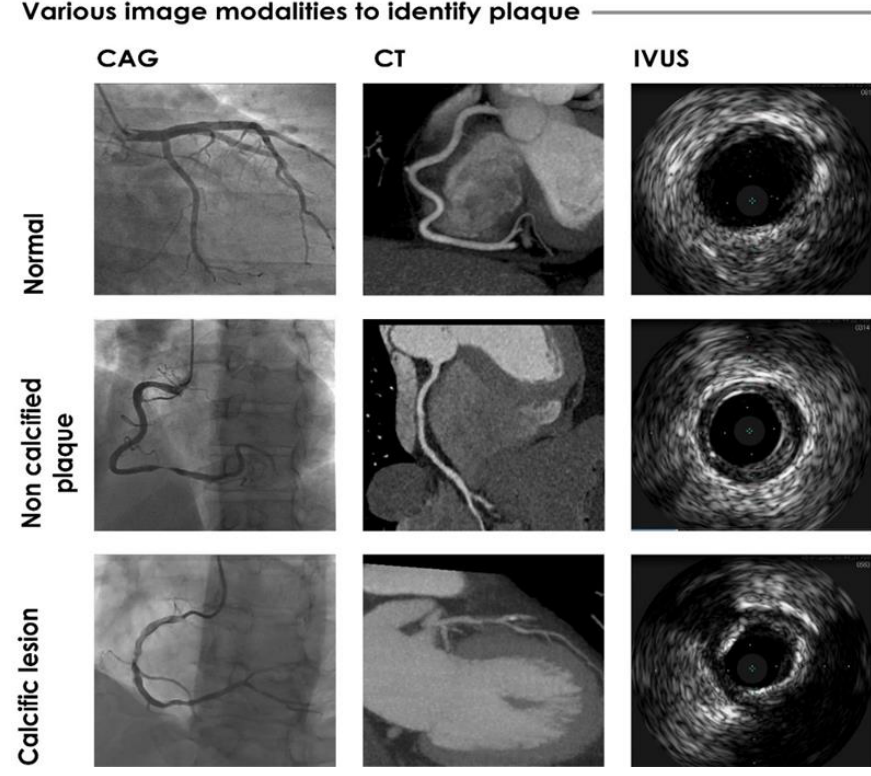
Figure 2. Sample images from invasive CAG, CT, and IVUS imaging techniques. Invasive CAG is the gold standard for coronary artery disease diagnosis based on detection of coronary lumen stenosis but is of limited utility for plaque characterization beyond outlining intracoronary thrombus associated with ruptured atherosclerotic plaque. Nevertheless, invasive CAG is a prerequisite for plaque characterization with IVUS and IVOCT. IVUS is the gold standard for assessment of the atherosclerotic coronary plaque [19,20]. A miniaturized ultrasound probe is introduced intra-luminally via an in- travascular catheter to the coronary lesion to obtain near-field two-dimensional cross-sec- tional high-resolution real-time images of the coronary lumen and atherosclerotic plaque with high echogenic grey-scale signal contrast [21,22]. IVUS is able to distinguish the inti- mal, medial, and adventitial layers of the arterial wall as well as various components of the atherosclerotic plaque, including the presence of dense calcium (DC), necrotic core (NC), fibrotic tissue (FT), and fibrofatty tissue (FFT) [23,24]. It yields comprehensive quan- titative information on lumen size, plaque components and presence of vulnerable plaque features or complications, e.g., TCFA or plaque surface rupture, which herald an immi- nent acute coronary event [25]. VH-IVUS uses spectral analysis of the backscattered grey- scale IVUS radiofrequency signals to augment tissue contrast among the various plaque components [26]. The results are displayed in color codes, which enhances visualization of pathology. Instead of sound waves, IVOCT exploits light waves to produce near-field plaque images with superior spatial resolution (approximately 15 um versus 150 um for IVUS) and tissue discrimination but less imaging depth (few millimeters versus five to ten millimeters for IVUS), which may unveil surface details not appreciated on IVUS [27]. Calcified plaque identification as well as discrimination between fibrous and lipid tissues are better with IVOCT than with IVUS.